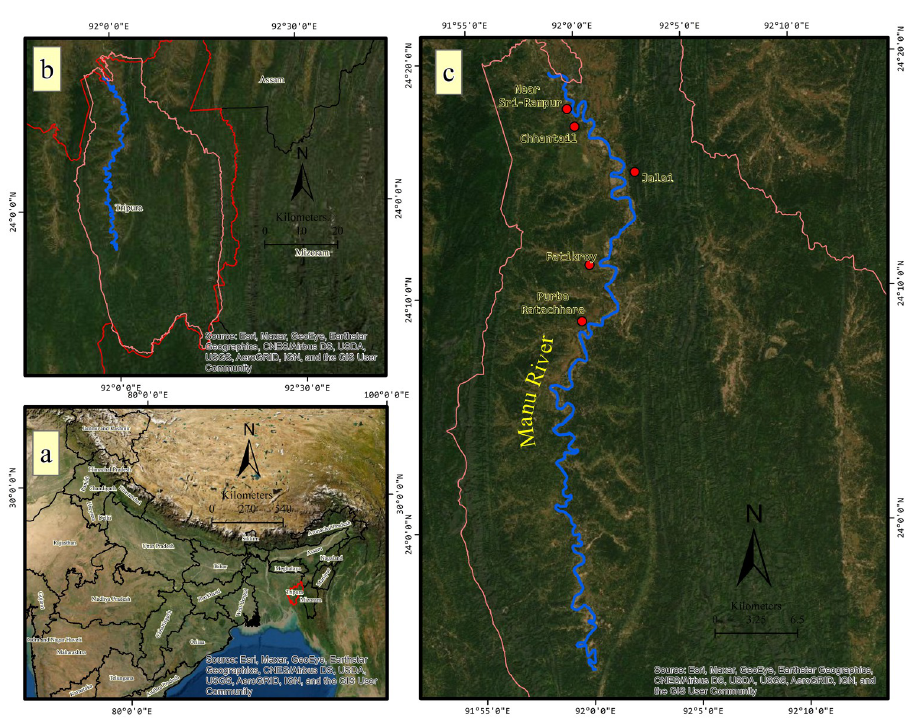
Fig 3. Location map of the study area, (a) The location of the state of Tripura with respect to the Union of India, (b) The basin boundary of the river Manu (pink), (c) River Manu. The map coordinates are in UTM WGS 84 North.